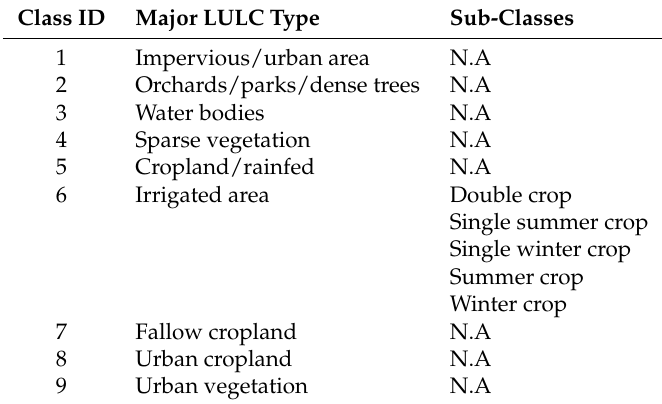
Class ID Major LULC